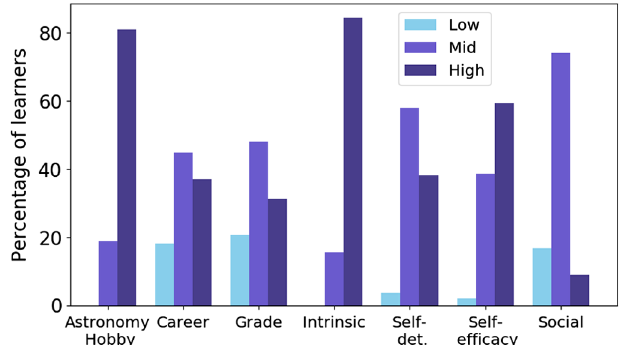
FIG. 3. Distribution of the average motivational scores for each of the motivational categories ( n ¼ 3701 ).